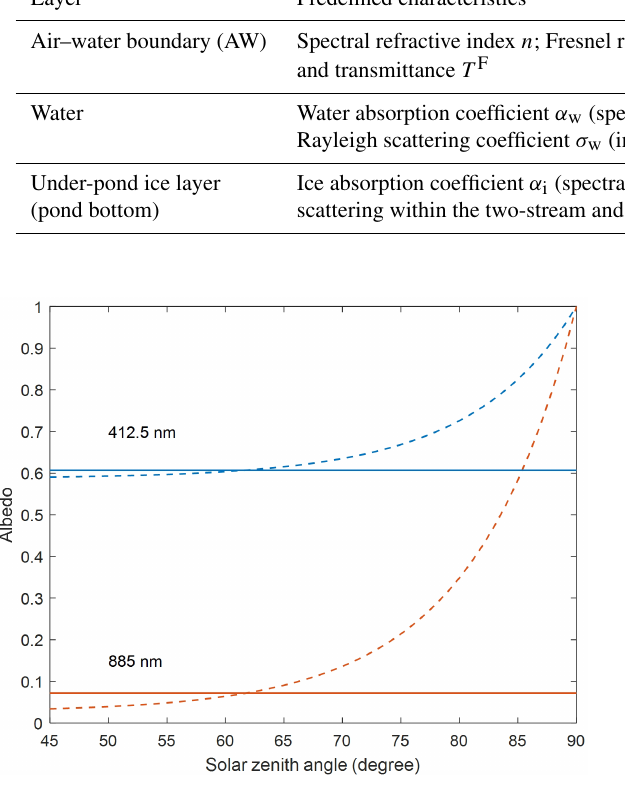
Figure 3. Black-sky albedo of a light melt pond ( z = 17cm, σ t = 3 . 2m − 1 , H = 1 . 25m) vs. the angle of incidence (dashed). The white-sky albedo values are shown in